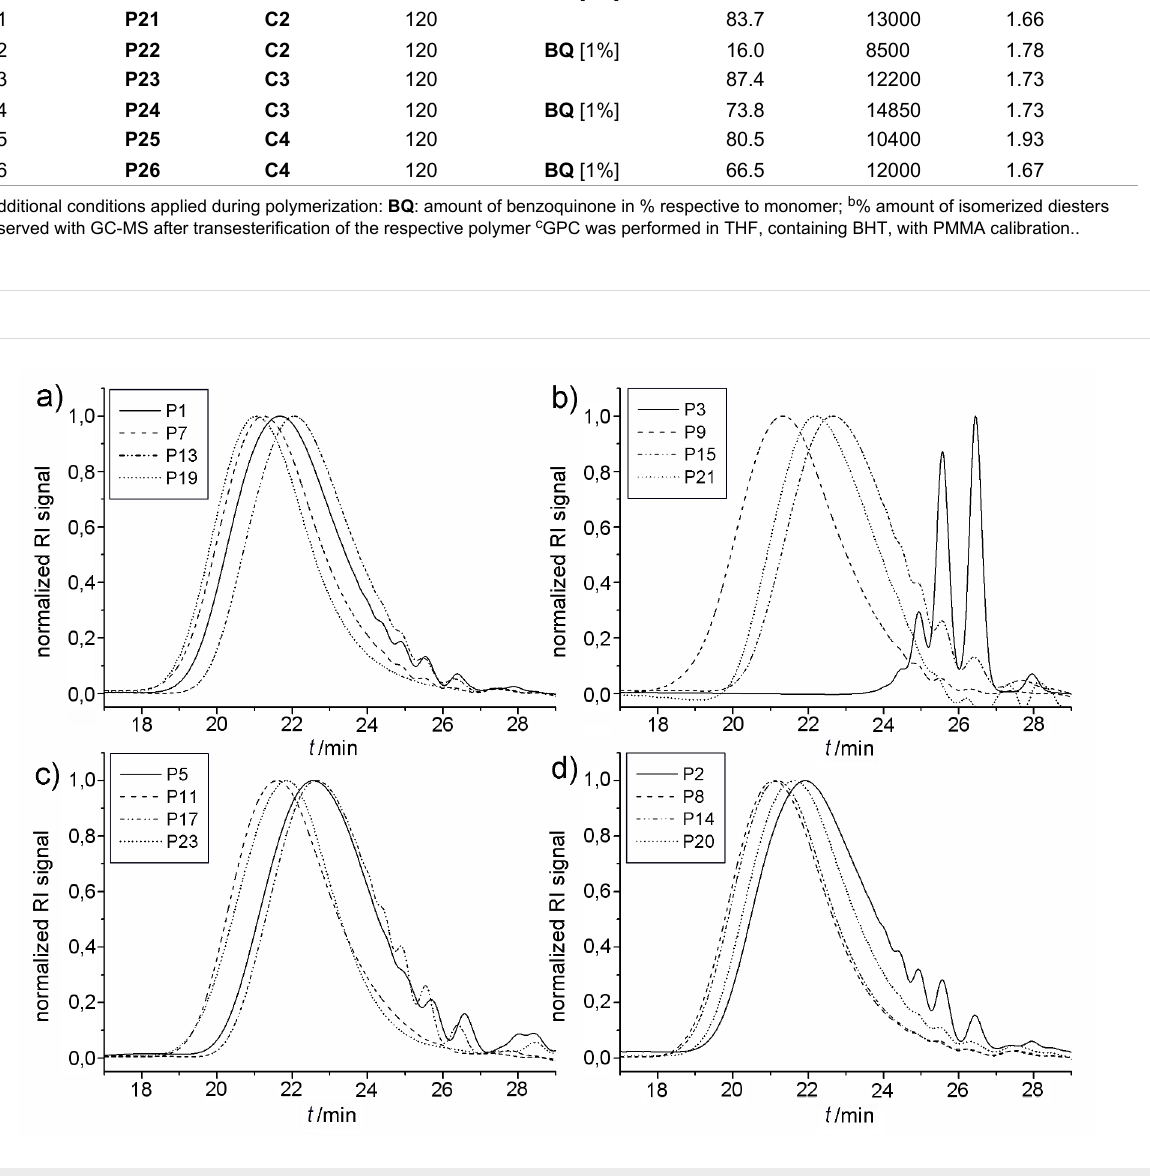
Figure 5: GPC traces of the polymerizations performed at 60, 80, 100 and 120 ºC in presence of a) 0.5 mol % C1 , b) 0.5 mol % C2 , c) 0.5 mol % C3 , and d) 0.5 mol % C1 with 1 mol % BQ